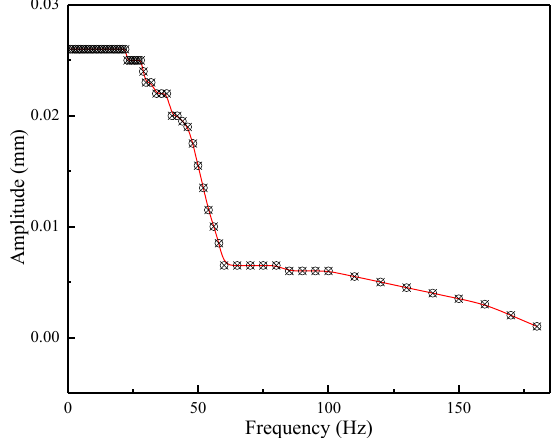
Figure 19. Amplitude frequency characteristics of the transducer.